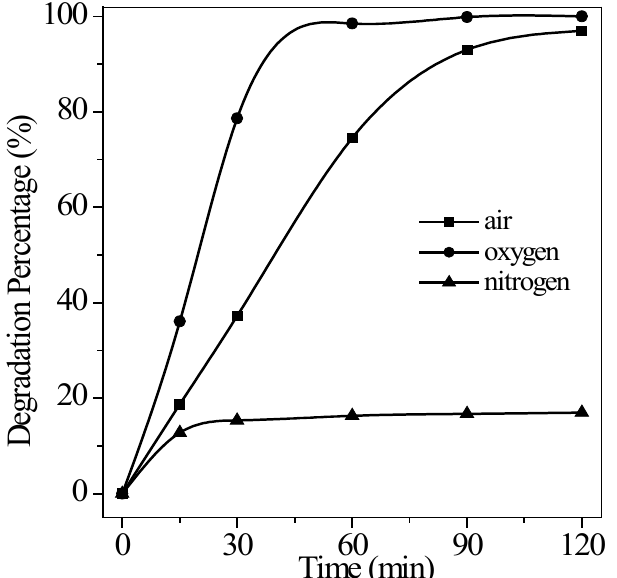
Figure 8. Effect of air, pure nitrogen, and pure oxygen aeration on the photodegradation of quinoline. Conditions: flow rate = 0.35 L/min, pH = 6.7, T = 17 °C, C maximum irradiation